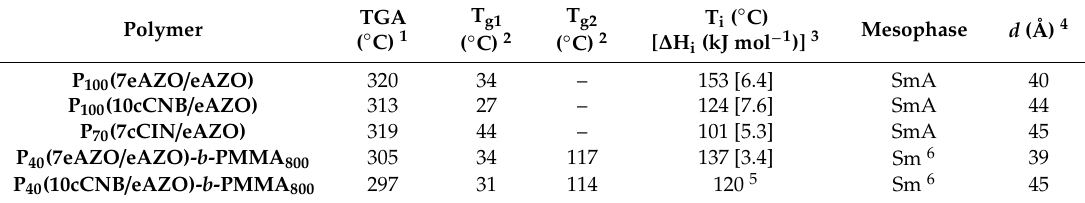
Table 2. Thermal Stability and Transition Temperatures of